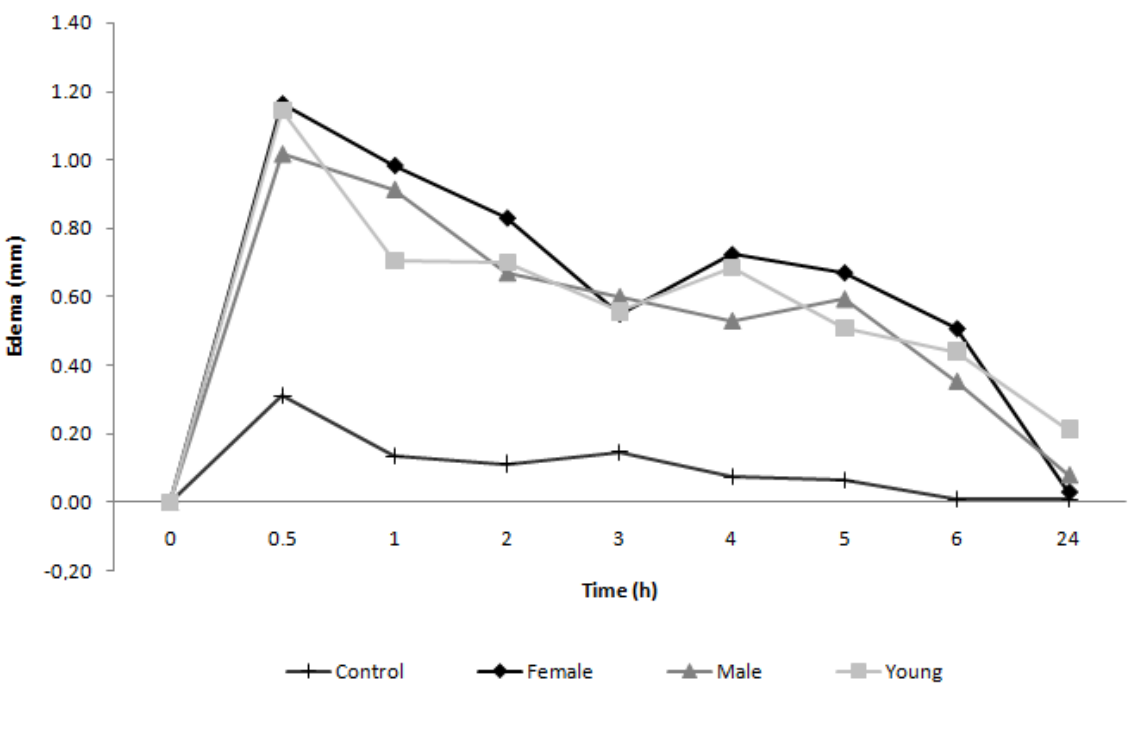
Figure 4. Edematous activity of C. d. cumanensis venom. BALB/c mice were inoculated with 2.5 μ g of each venom into the subplantar region of the hind paw. Hemorrhagic and Hemolytic